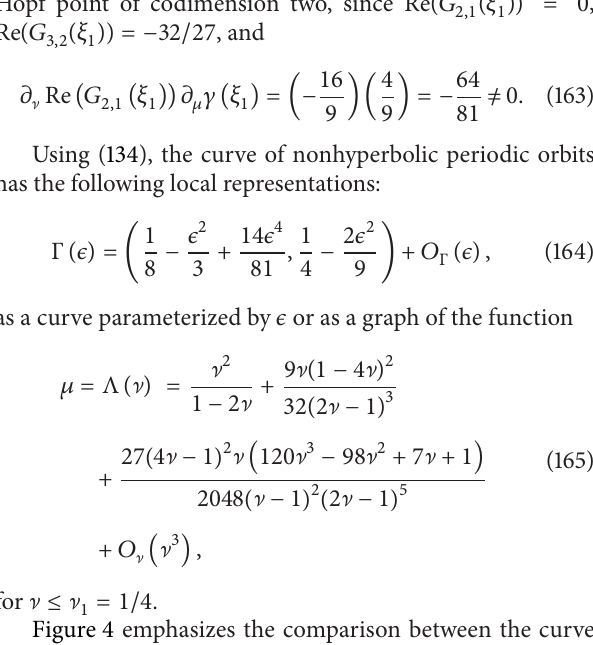
Figure 4 emphasizes the comparison between the curve of nonhyperbolic periodic orbits 𝐶